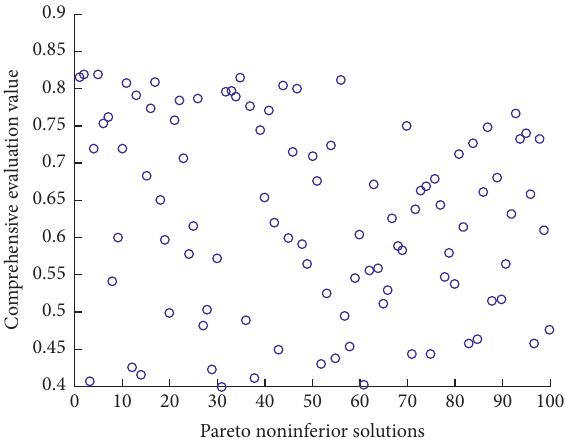
Figure 13: Comprehensive evaluation value and distribution of Pareto noninferior solutions. Table 3: Comparison of the various indexes before and after optimization of horizontal vibration reduction. The first-order natural The second-order natural Peak-to-peak value of the horizontal Items to be compared frequency (Hz) frequency (Hz) vibration acceleration (m/s 2 ) Before the optimization of 0.350 vibration reduction After the optimization of vibration reduction